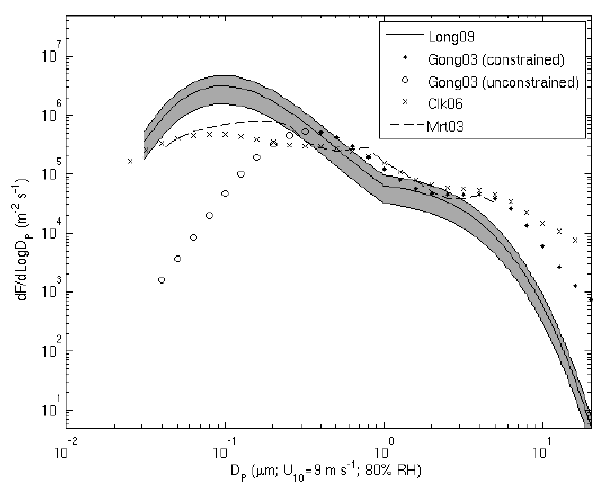
Fig. 2. Size-resolved number production fluxes based on Long10 compared with those based on Gong03, Clk06, and Mrt03 at 80% RH and U 10 = 9ms − 1 . Because fluxes predicted by the other pa- rameterizations are based on measurements of inorganic sea salt de- void of OC aer (see text), fluxes depicted for Long10 correspond to those at 0.0 mg chl- a m − 3 (i.e. also devoid of OC aer ) . The shaded area depicts combined measurement-based uncertainty associated with the entrainment of the bubble plume and particle production. Readers are referred to the cited literature for uncertainties asso- ciated with the other parameterizations. Open and closed circles for Gong03 depict predicted fluxes that are within and outside, re- spectively, the ranges of constraining measurement from which the function was